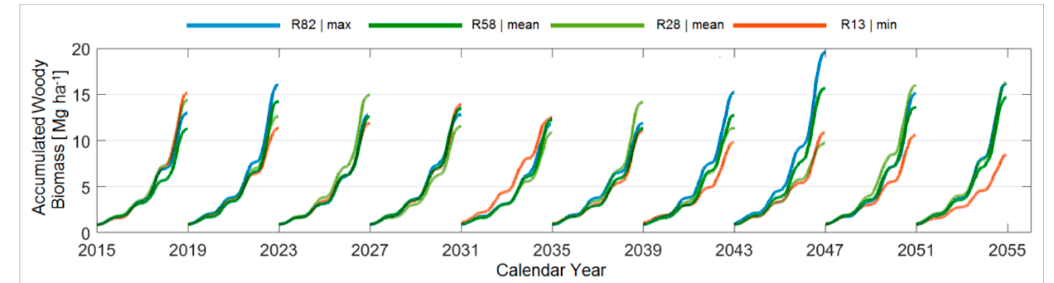
precipitation sum values during the vegetation period from 2015 to the end of 2054.